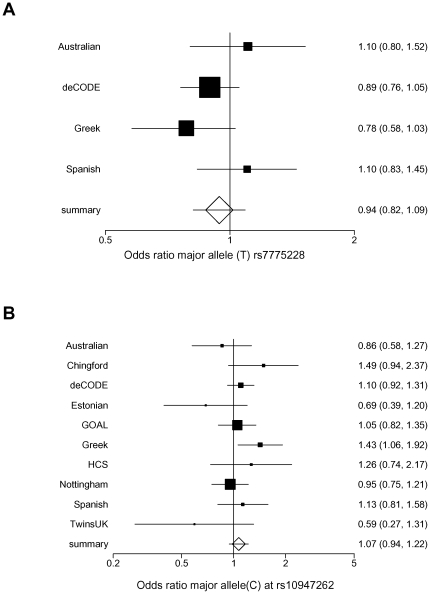
Meta-analysis of genetic association between two HLA SNPs and knee OA.Forest plot of study-specific estimates and random-effects summary effect size and 95% confidence intervals (95%CIs) for the genetic association with knee OA of (A) the major allele (T) at rs7775228 in three published studies and the deCODE case-control study (B) the major allele (C) at rs10947262 in three published studies and seven additional European studies. Square sizes are proportional to the number of cases in each study.